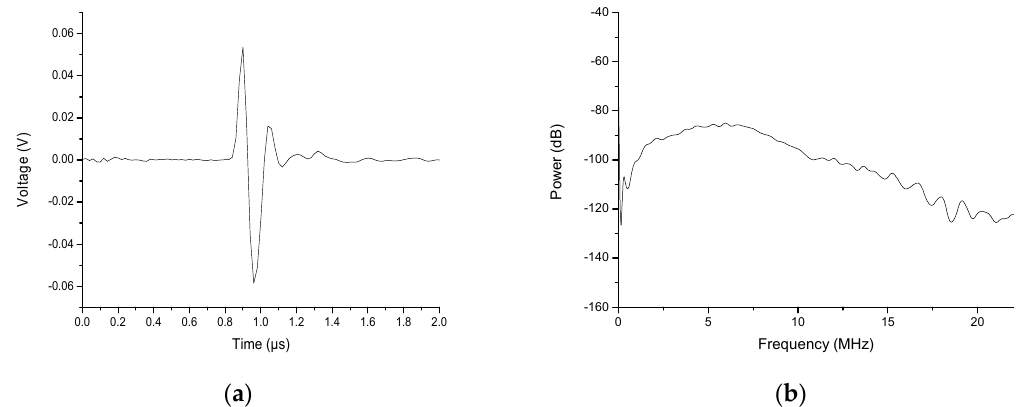
Figure 2. The ultrasonic signal generated by the fiber optic ultrasonic generator. ( a ) The profile of a generated ultrasonic signal. ( b ) The frequency domain of the generated ultrasonic signal.